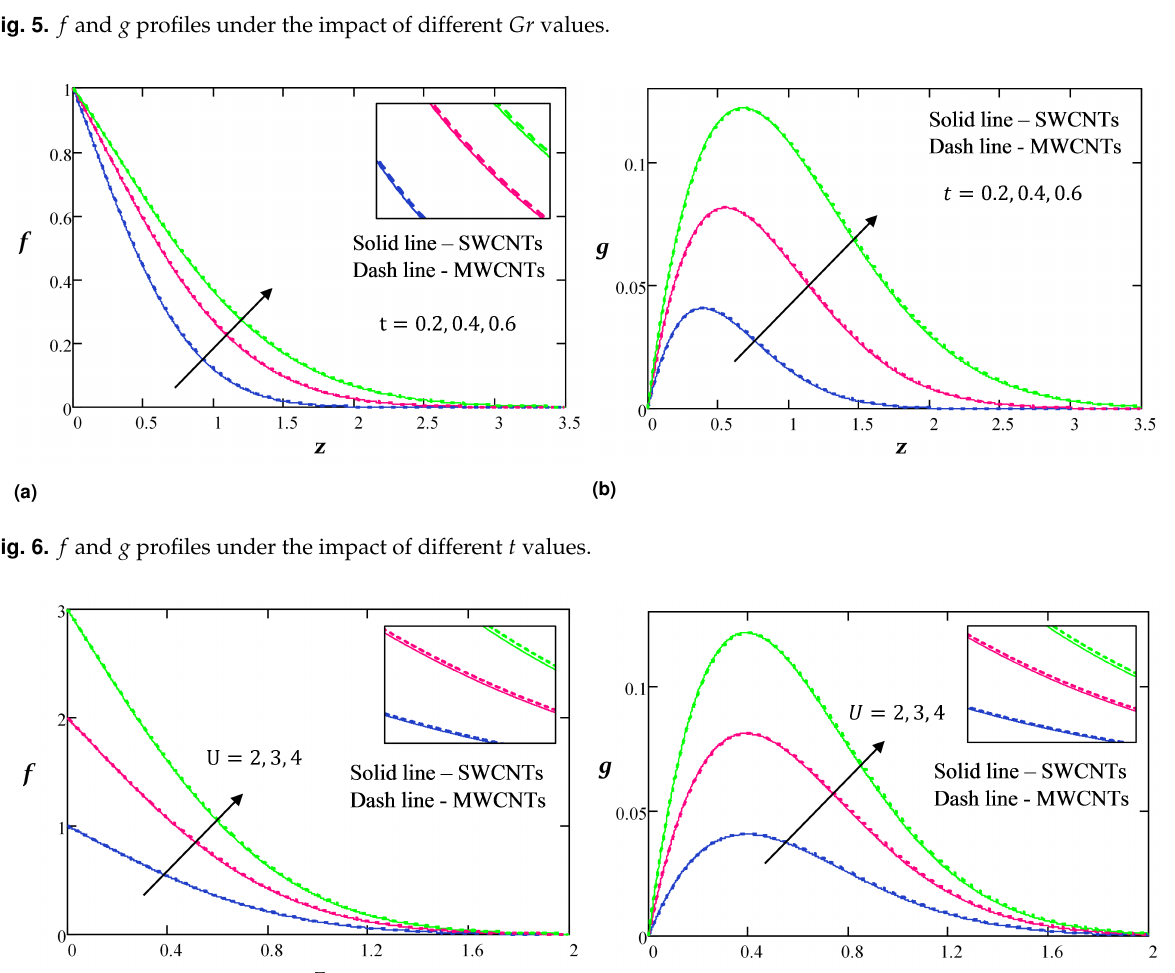
SWCNTs due to their low